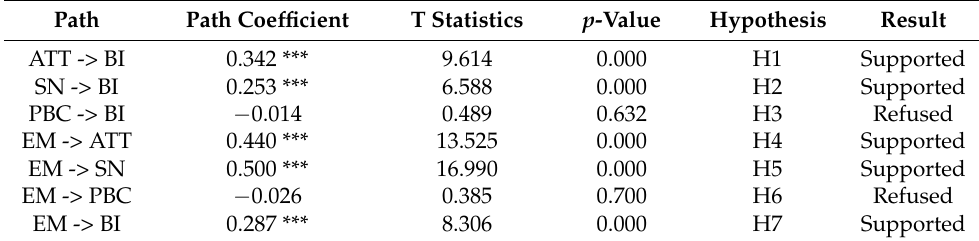
Table 5. Model path coefficient and hypothesis testing results.